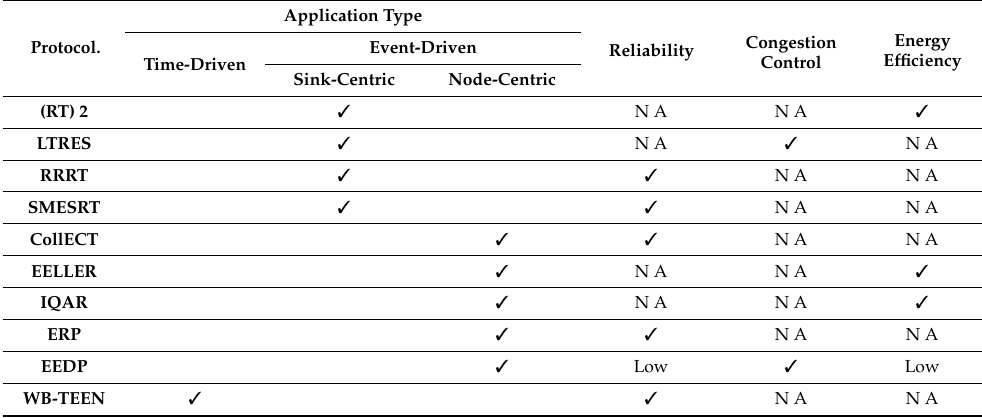
Table 2 establishes a comparison between “application type”-based routing protocols [43]. Table 2. Comparison of application type-based routing protocols for WSNs.